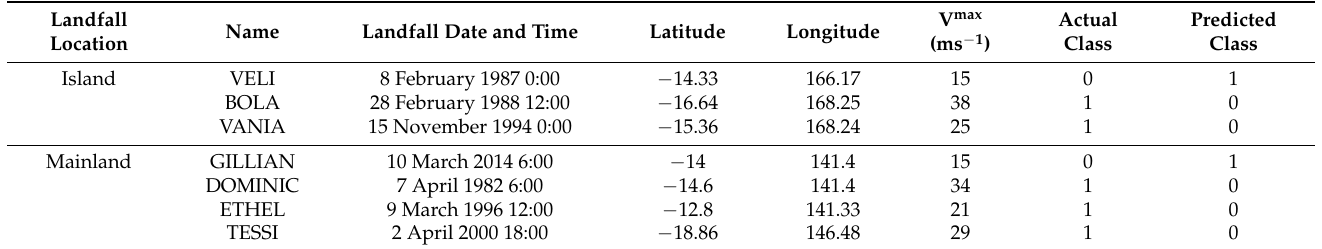
Table 7. Number of incorrect predictions from island and mainland models, their landfall date and time, geographic location, Vmax, actual class and predicted